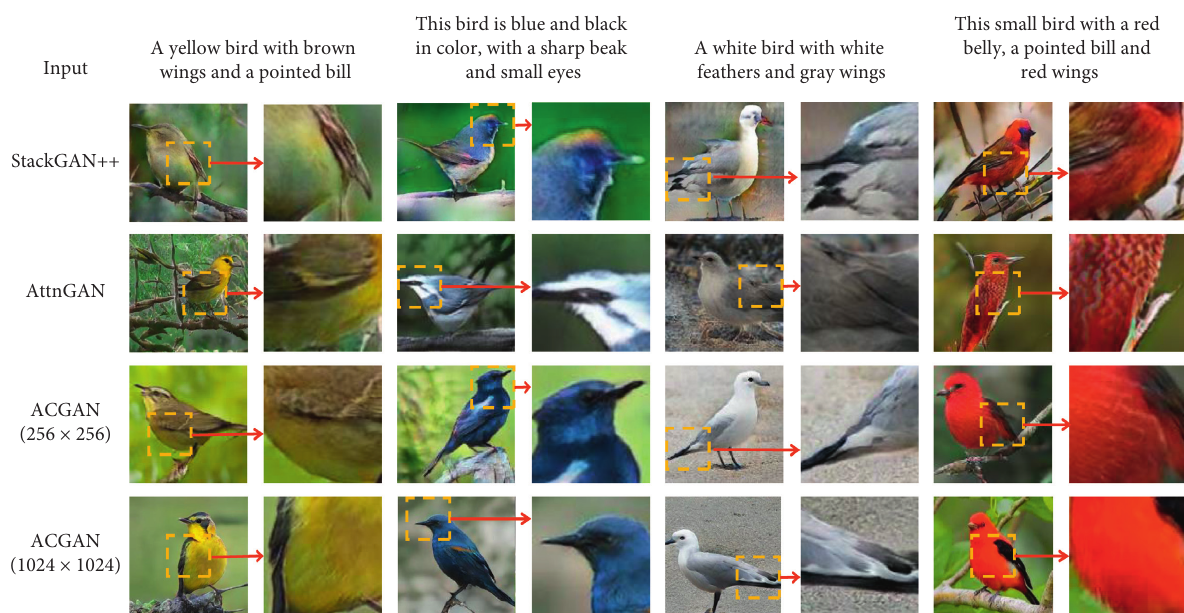
Figure 4: Details (beak, wings) comparison of the images generated from descriptions using three GAN models trained on CUB test